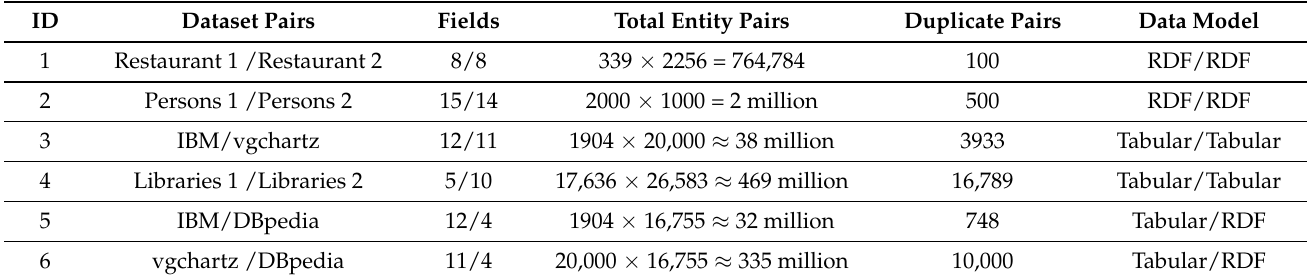
Table 3. Details of dataset pairs. The notation, where applicable, is (first dataset)/ × (second